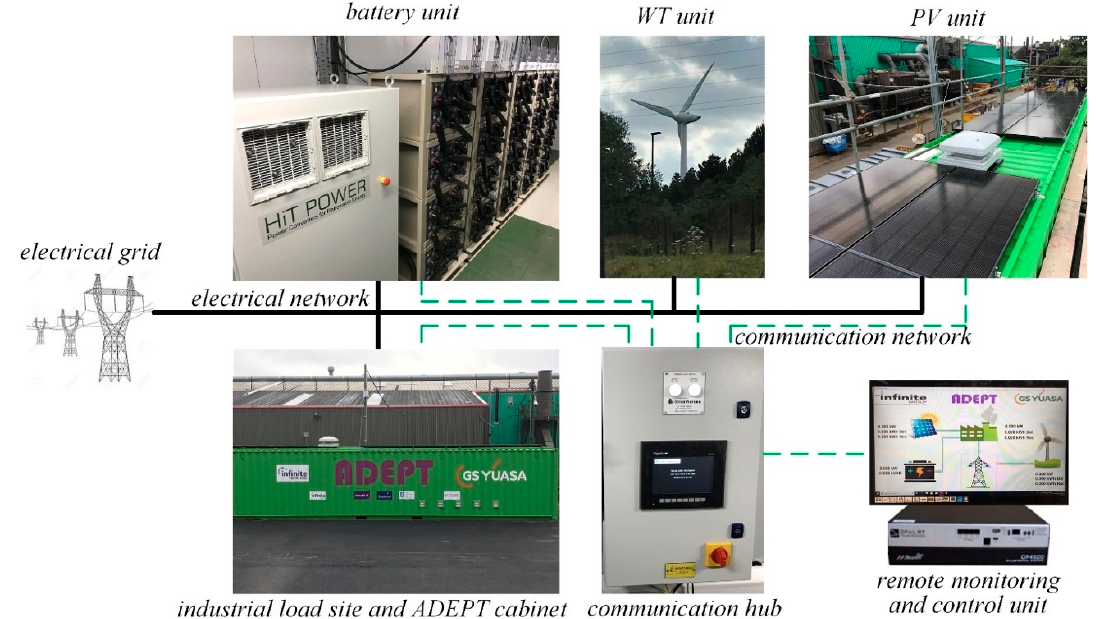
Figure 5. The ‘ADvanced multi-Energy management and optimization time shifting PlaTform’ (ADEPT) Figure 5. The 'ADvanced multi-Energy management and optimization time shifting PlaTform’ micro-grid architecture. (ADEPT) micro-grid architecture.